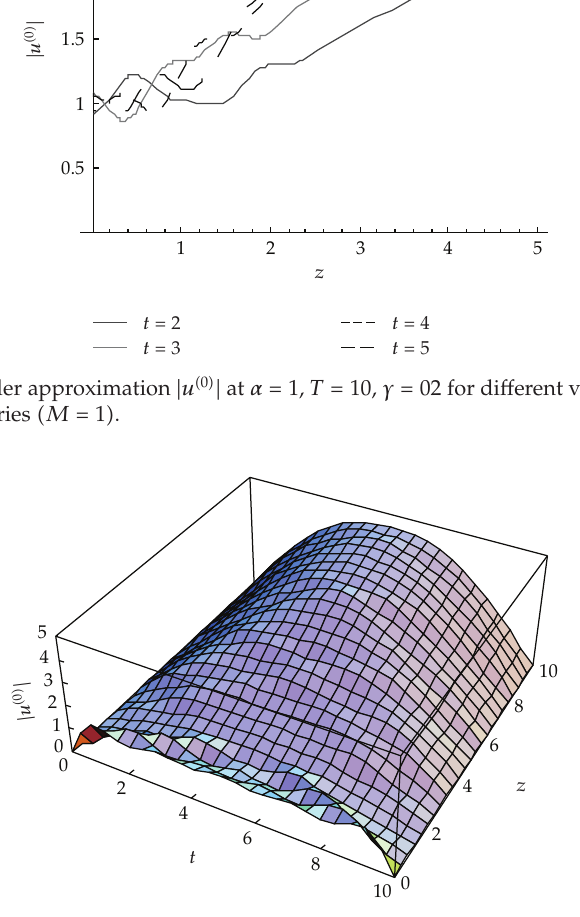
Figure 16: The zero-order approximation of | u (cid:3) 0 (cid:4) | at α (cid:8) 1, T (cid:8) 10, γ (cid:8) 02 with considering only one term in the series (cid:3) M (cid:8) 1 (cid:4)